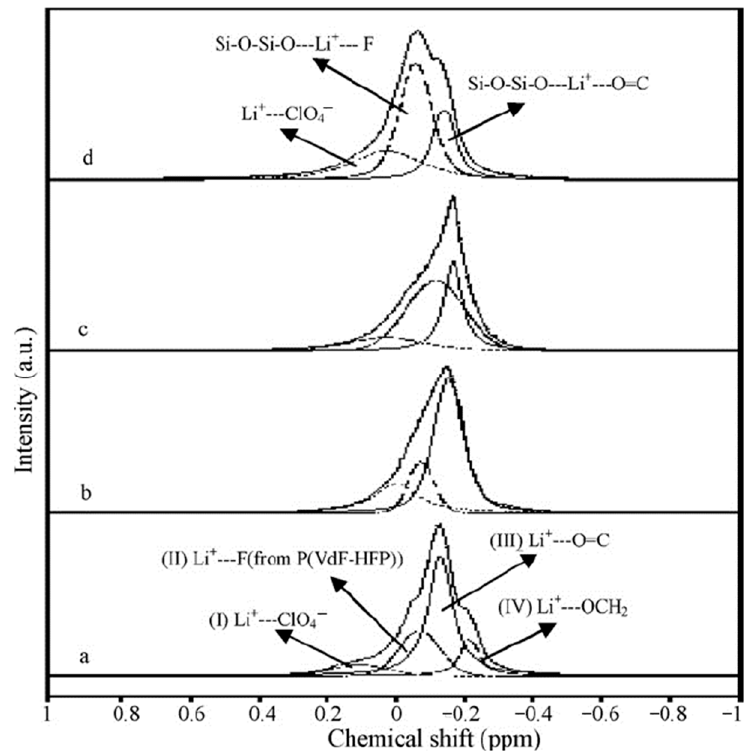
Figure 9. MAS 7 Li spectra of (PVDF-HFP)-(PC + EC)-LiClO 4 -SAG. Component contents (wt %): 20:70:10:0 ( a ), 20:69:10:1 ( b ), 20:66:10:4 ( c ), 20:64:10:6 ( d ). Spinning frequency is 2 kHz [122]. The 7 Li diffusion decay is approximated by Equation (1) [126], Figure 10.